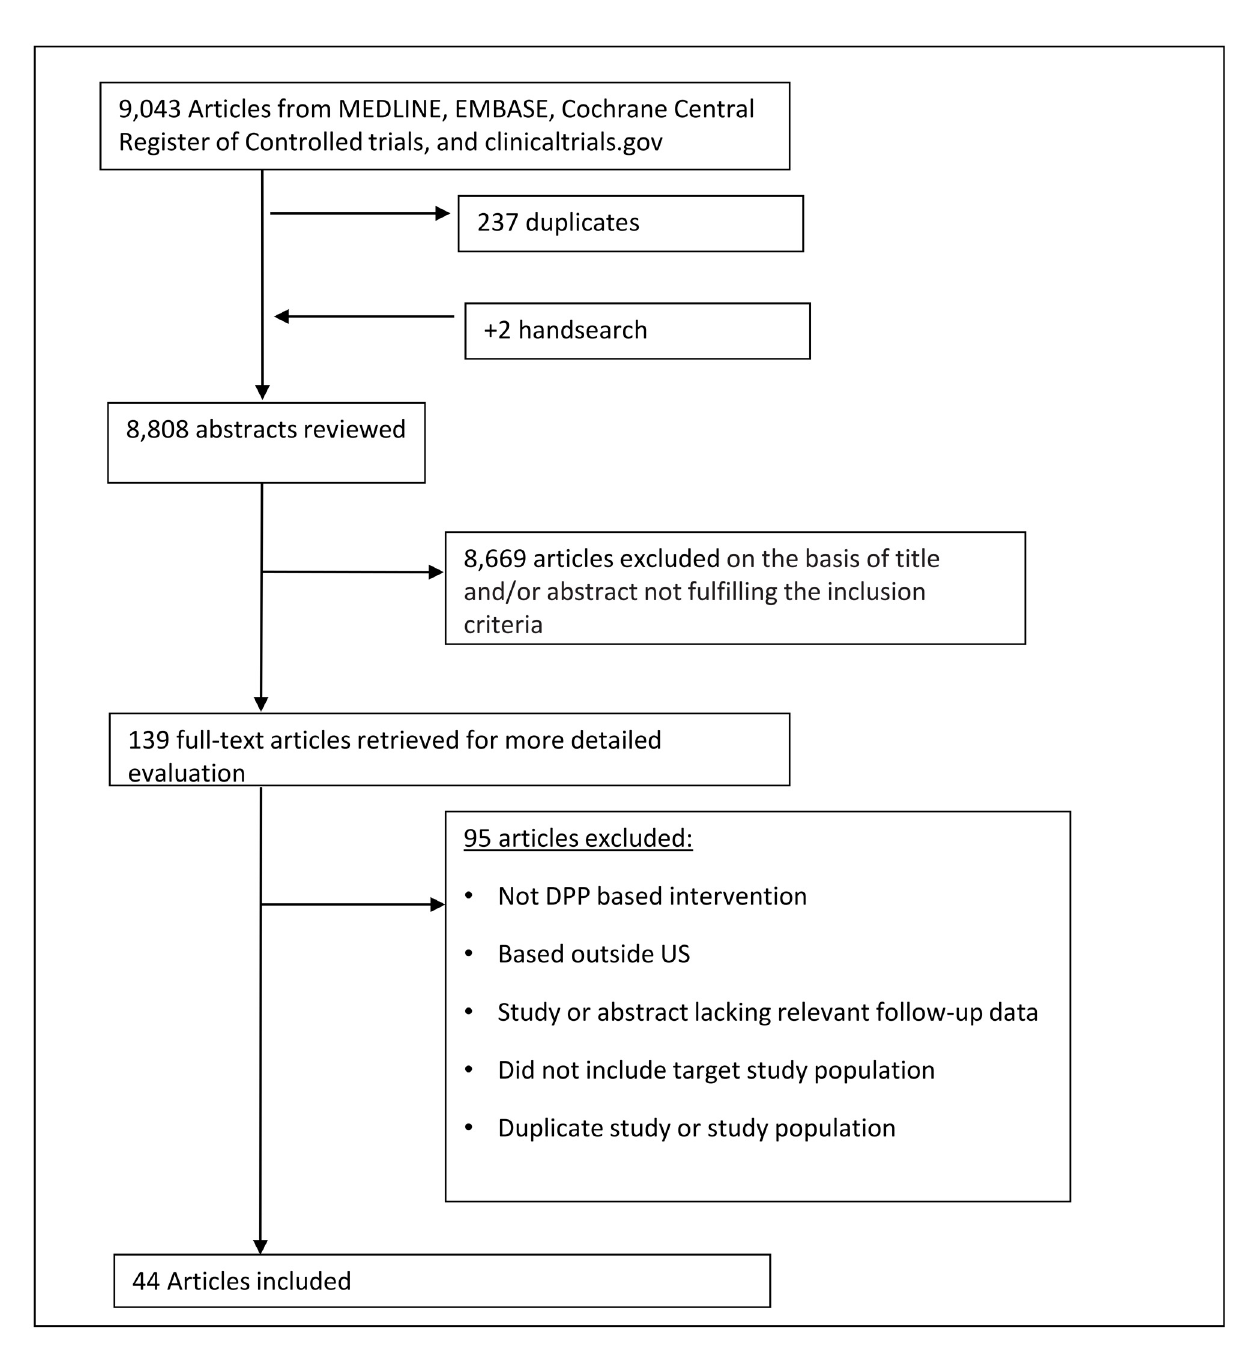
Fig 1. Flow diagram of study search. This flow chart describes the number of studies that were involved in each step of the process of study selection, from the initial study search. After the application of inclusion and exclusion criteria, 44 studies met criteria and were included in the final